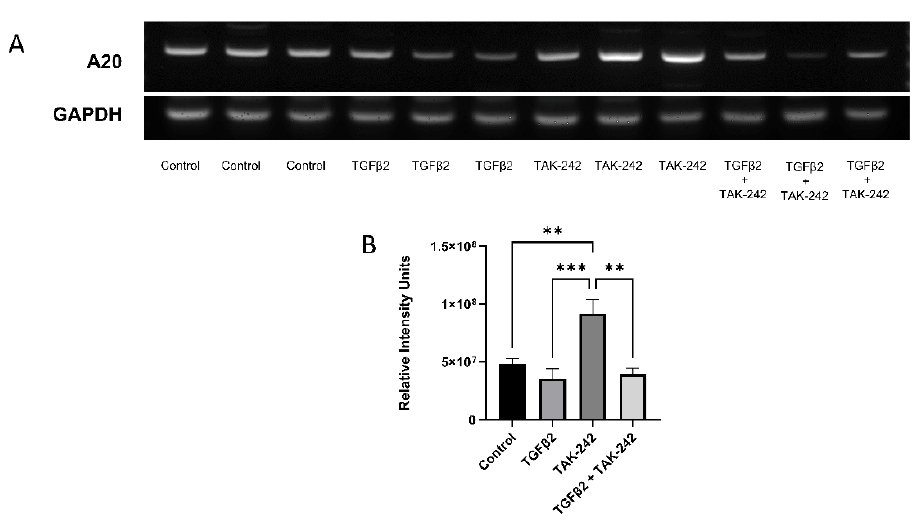
Figure 2. A20 gene expression in primary human TM cells increased with selective inhibition of the TLR4 pathway. ( A ) RT-PCR was performed after the indicated treatments with primers specific for human A20 and the housekeeping gene GAPDH. ( B ) A20 gene expression was significantly elevated by TAK-242 treatment. Statistical significance was determined by one-way ANOVA with Tukey post-hoc analysis, with p < 0.05 considered statistically significant. Error bars show SEM. ** = p ≤ 0.01, *** = p ≤ 0.001.